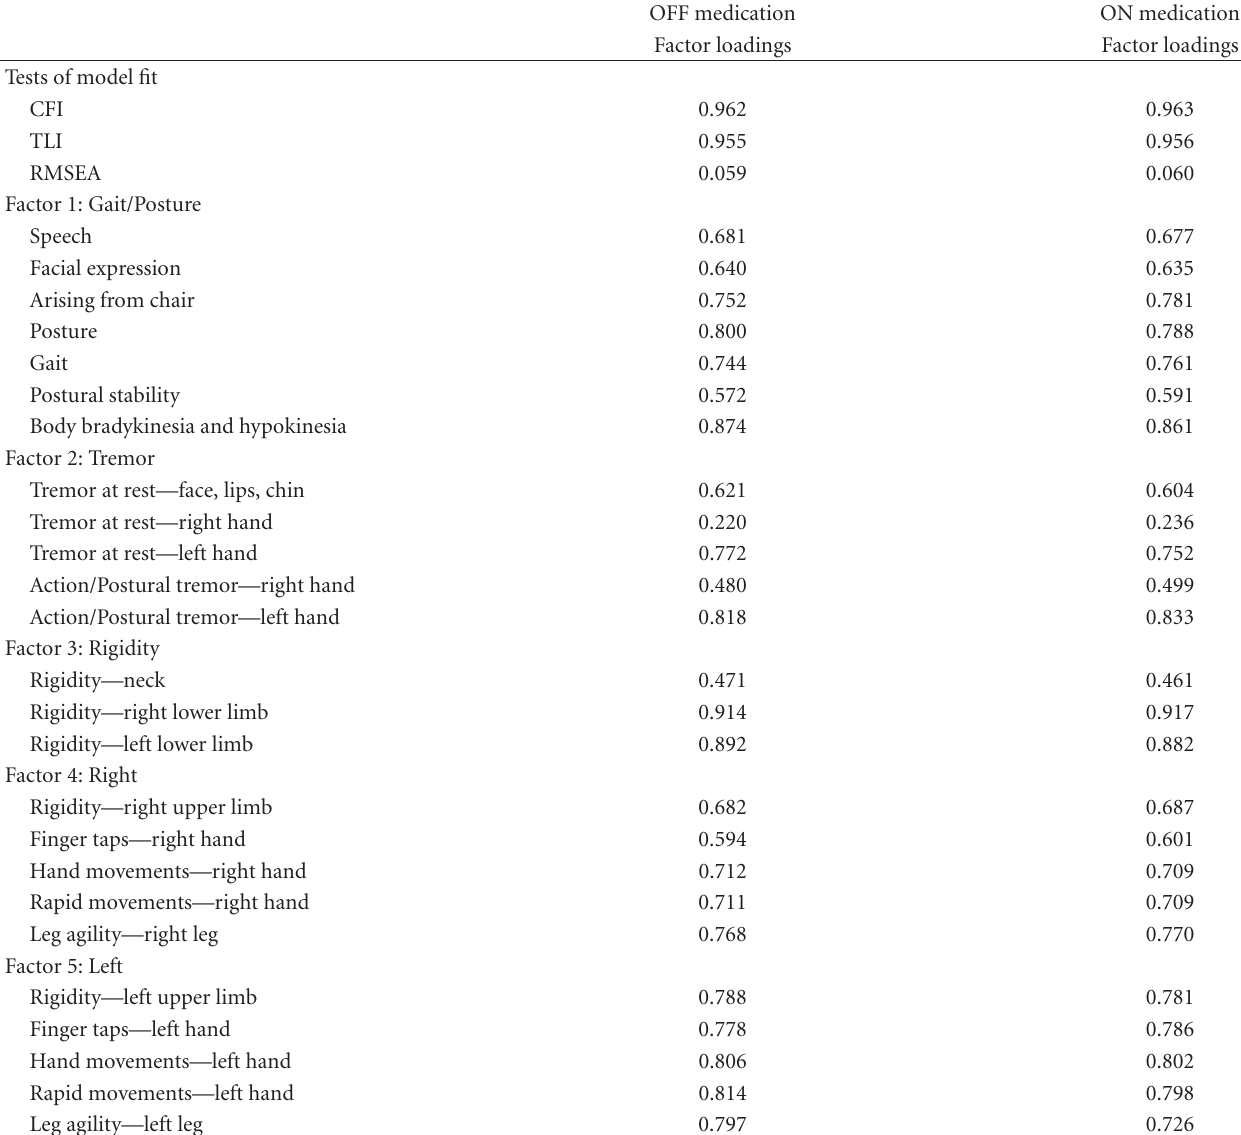
Table 2: Factor loadings for confirmatory factor analysis o ff and on Parkinson disease